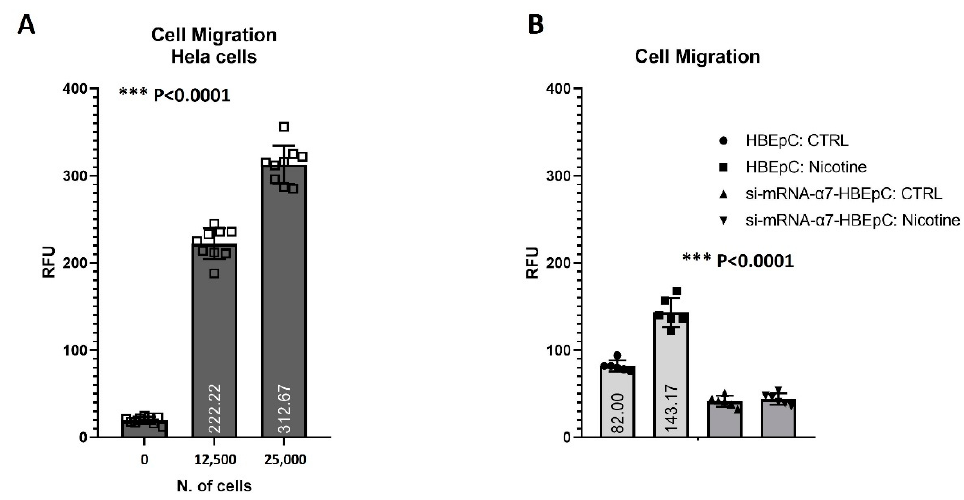
Figure 10. Cell migration to nicotine for 48 h in HBEpC and/or si-mRNA- α 7-HBEpC. HeLa cells are positive control. ( A ) HeLa positive control. ( B ): Cell migration h in HBEpC and/or si-mRNA- α 7- HBEpC. Statistical significance is analyzed with one-way ANOVA with multiple-comparison and post hoc test with Bonferroni correction. Experiments are performed at least two times in triplicate.